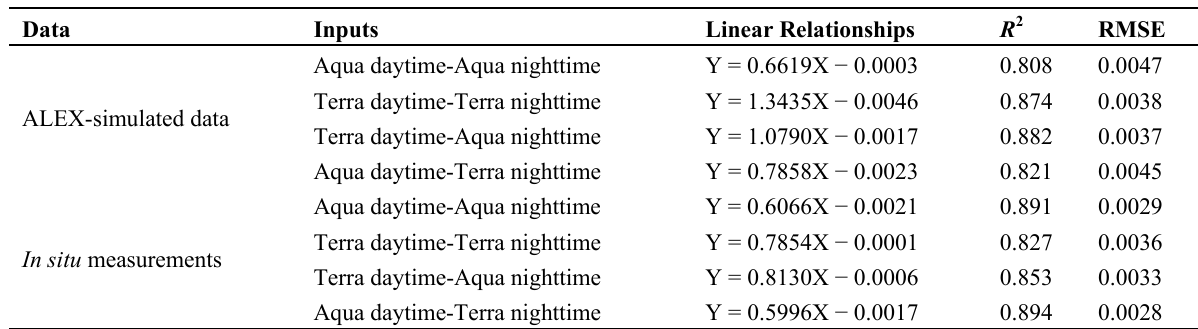
′ ( t ) − T ′ ( t ))/ R ′ ( t ) s a n